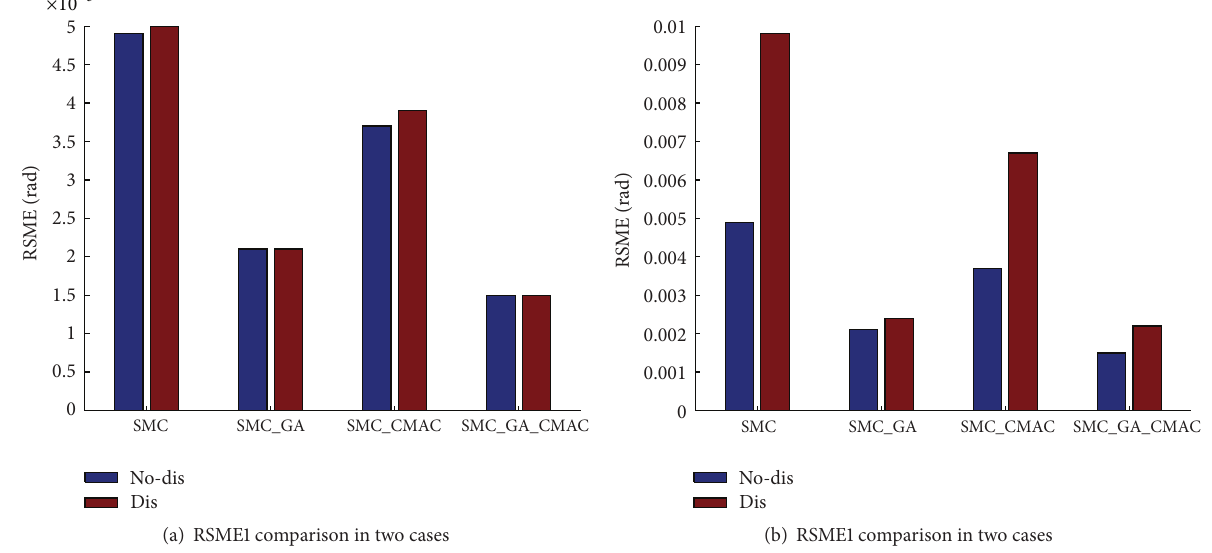
Figure 11: RSME1 and RSME2 comparisons in two cases. Icon “No-dis” means Case One and “Dis” means Case Two, respectively.